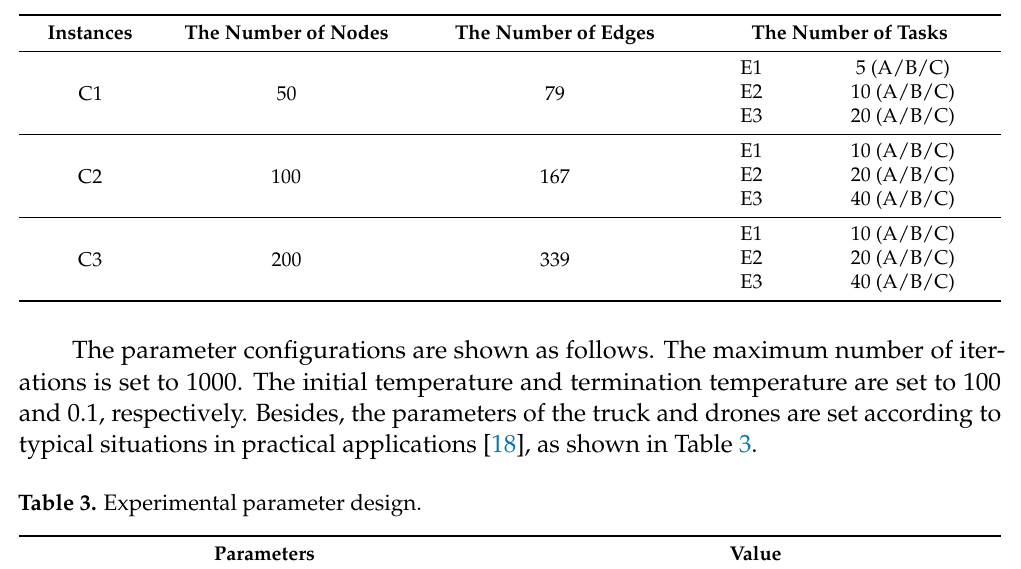
Table 3. Experimental parameter design.